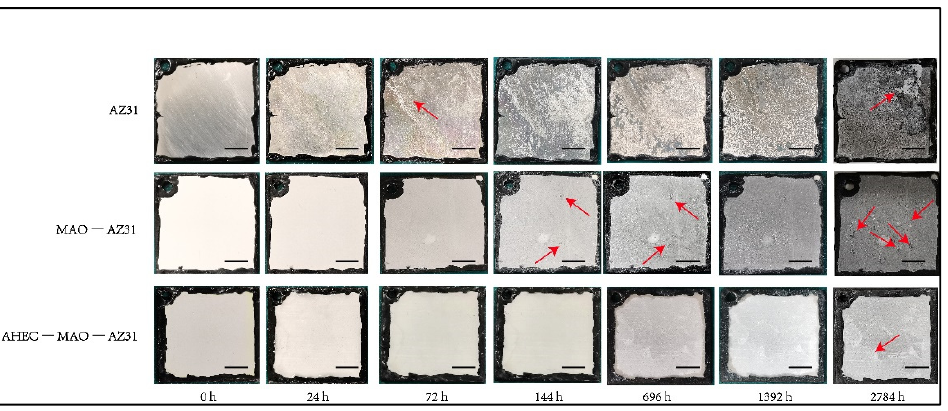
Figure 8. Long-term soaking diagram of each group. The red arrows indicate corrosion points. Scale bar = 5